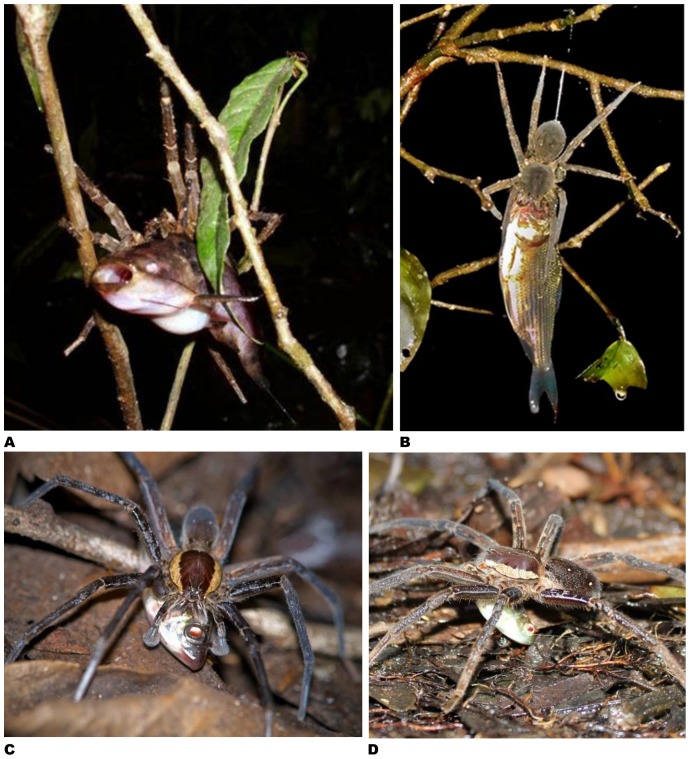
Fish caught by spiders – examples from the Neotropics.
A – In marshy area in Cuyabeno Wildlife Reserve, Ecuador, adult Ancylometes sp. (probably Ancylometes rufus) lifted catfish - most likely family Pimelodidae - out of the water (photo by Craig Harrison, Hertford, UK; report # 57). B – Ctenid spider (Ancylometes sp.) feeding on characiform in Tahuayo river area de Conservacion Regional Communal Tamshiyacu-Tahuayo Loreto, Peru (photo by Alfredo Dosantos Santillan c/o Amazonia Expeditions, Tampa, USA; report # 60). C – Adult male of Ancylometes sp. (possibly Ancylometes rufus) caught characiform (Cyphocharax sp.) near Samona Lodge, Cuyabeno Wildlife Reserve, Ecuador (photo by Ed Germain, Sydney, Australia; report # 52). D – Adult Ancylometes sp. preying on characiform near Samona Lodge, Cuyabeno Wildlife Reserve, Ecuador (photo by Tim Wohlberg, Kelowna, BC Canada; report # 53).